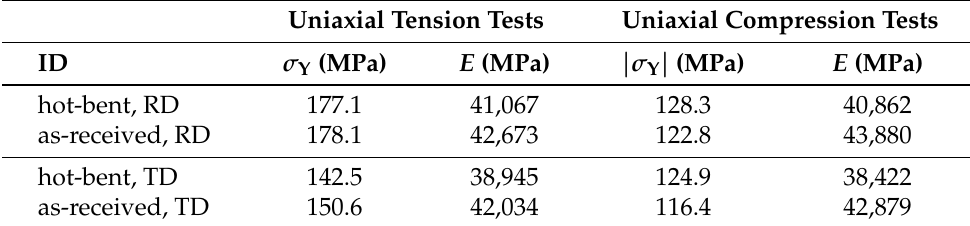
Table 3. Results of the yield stresses σ Y and the Young’s moduli E from the uniaxial tension and compression tests. These tests are carried out with the as-received and the hot-bent material in RD and TD.